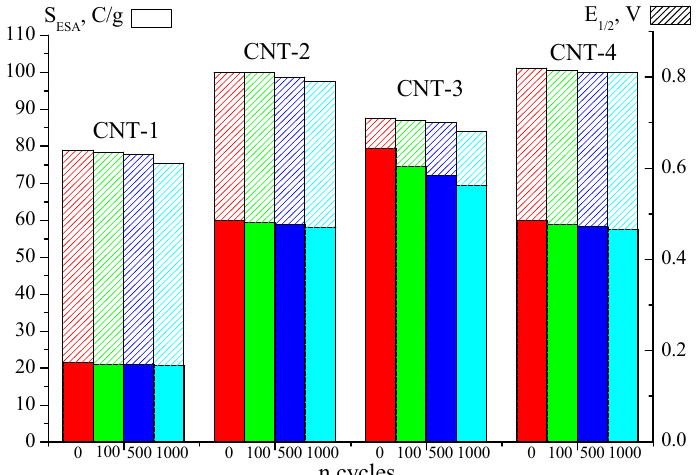
Figure 4. Variation of the S EAS and Е 1/2 parameters of modified CNTs during accelerated corrosion testing in 0.1M KOH.